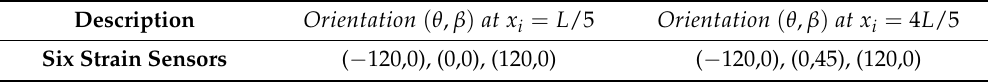
Table 1. Description of the optimal placement for six strain sensors; angles are expressed in